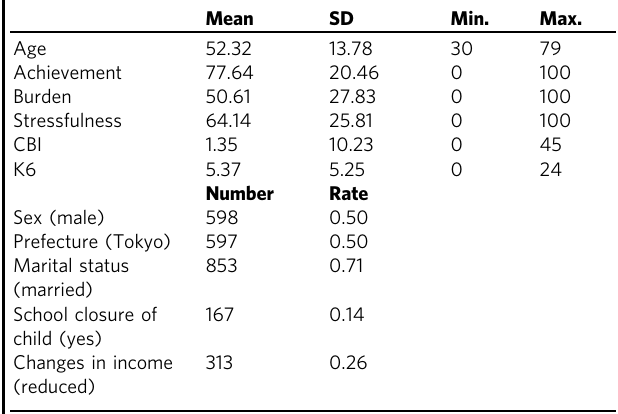
Supplementary Table S2. Brie fl y, the psychological burden of